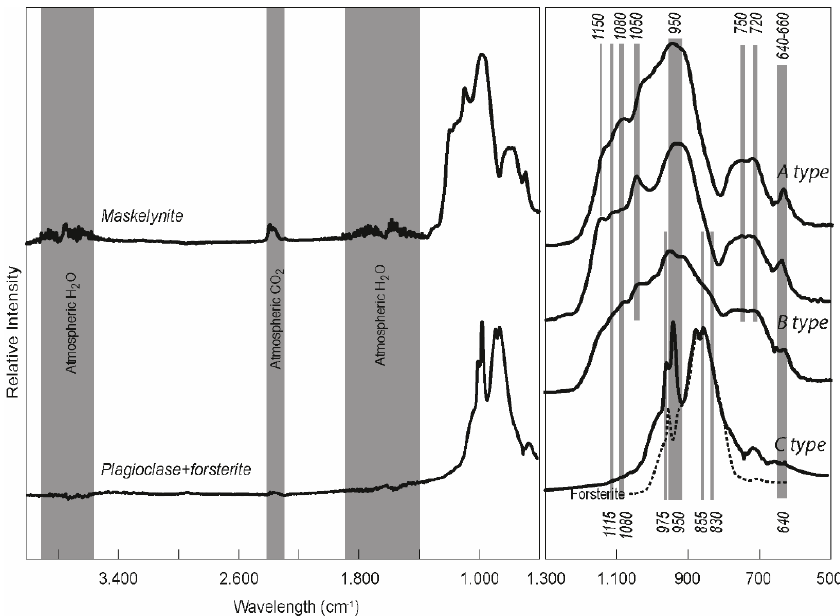
Figure 7. FTIR spectra of maskelynite/plagioclase in three different types, based on peak positions and different grades of crystallinity.